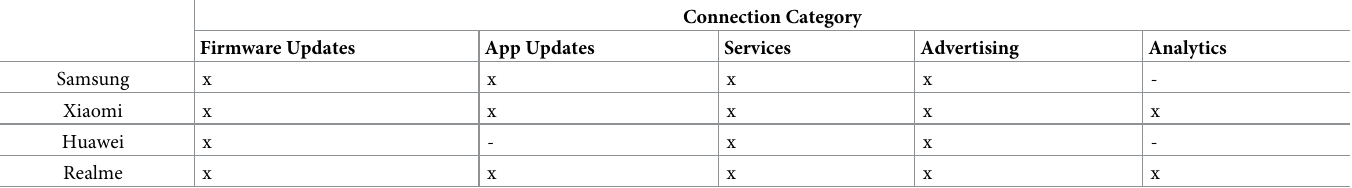
Table 4. Connection categories sending device hardware/system configuration data.